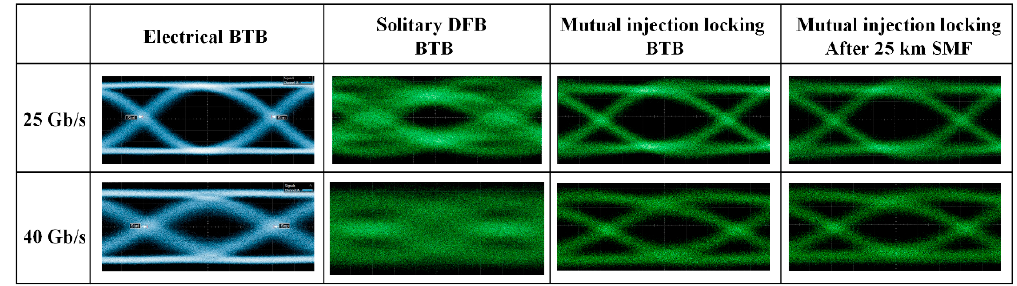
Figure 10. The 25 and 40 Gb/s non-return-to-zero eye diagrams of the solitary DFB and IMC lasers under the MIL state for back-to-back (BTB) configuration and eye diagrams of the IMC laser under the MIL state for 25-km SMF transmission.